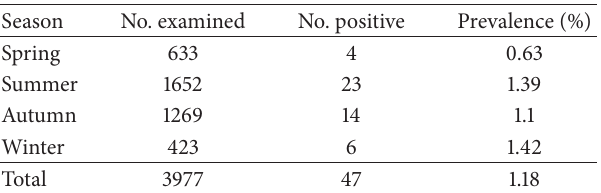
Table 2: Prevalence of Sarcoptes scabiei infection in pet dogs of different age groups in Guangzhou, southern